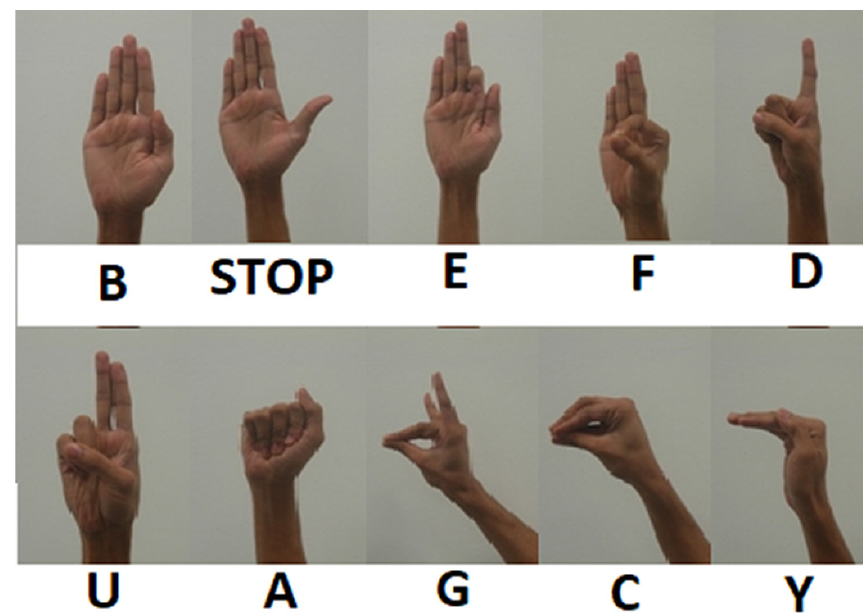
Fig. 3. Grammar to interpret